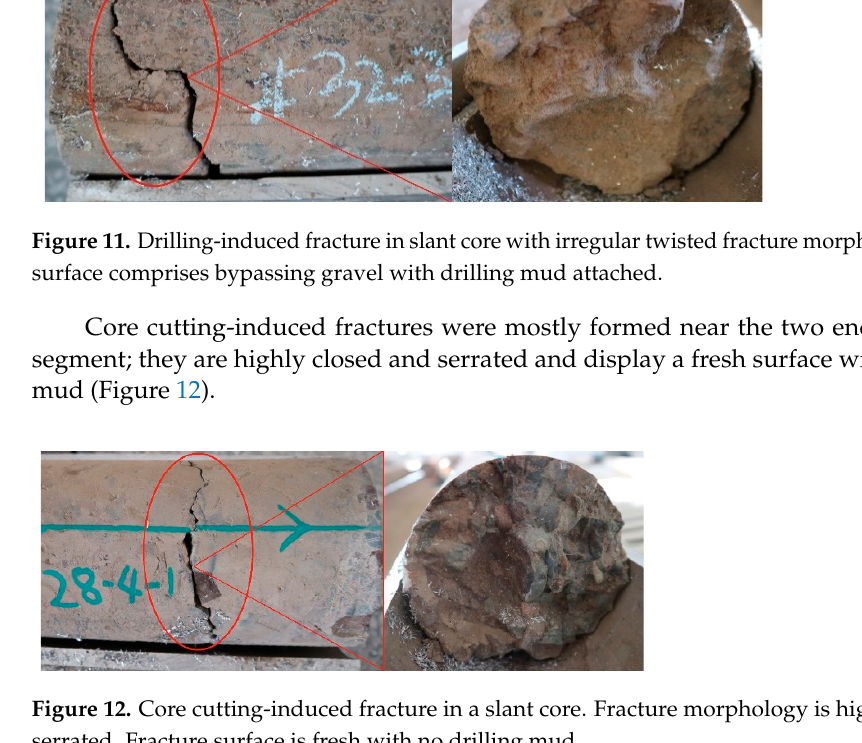
Figure 12. Core cutting-induced fracture in a slant core. Fracture morphology is highly closed and serrated. Fracture surface is fresh with no drilling mud.